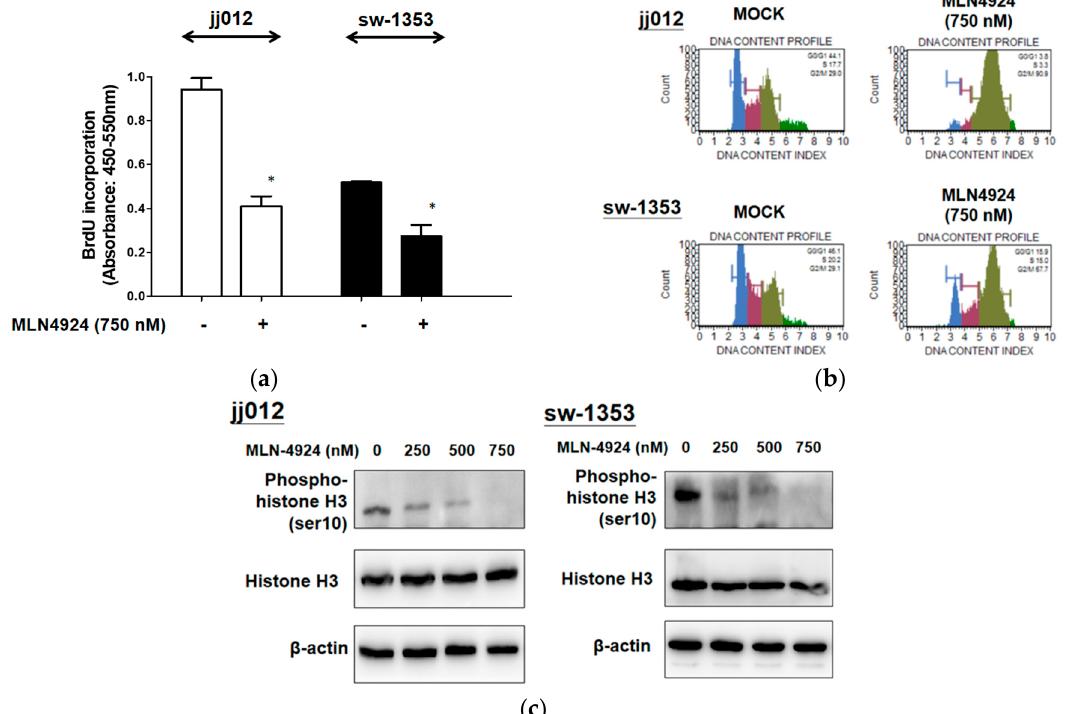
Figure 2. MLN4924 inhibited cell proliferation and caused G2/M cell cycle arrest in two human chondrosarcoma cells. ( a ) The jj012 and sw-1353 cells were exposed to mock (untreated) treatment or MLN4924 treatment (750 nM) for 48 h. After incubation, the status of DNA synthesis in terms of representing cell proliferation was determined using a BrdU incorporation assay. ( b ) Starved jj012 and sw-1353 cells were treated with or without various concentrations of MLN4924 for 24 h. After treatment, cells were subjected to propidium iodide (PI) staining to determine DNA content. ( c ) jj012 and sw-1353 cells were treated with or without various concentrations of MLN4924 (250, 500, and 750 nM) for 48 h. After treatment, the expression levels of cell cycle regulatory proteins, including histone-H3 and phospho-histone-H3 (Ser10), in total cell lysates were analyzed using Western blot analysis. The results are representative of at least three independent experiments. * p < 0.05.